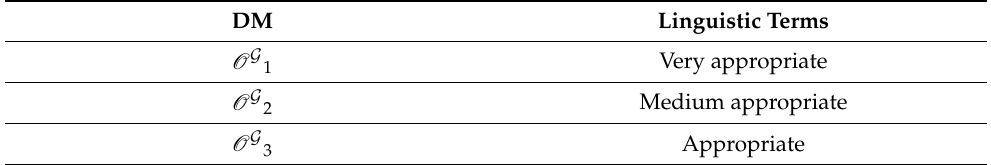
Table 4. Linguistic terms for DMs.